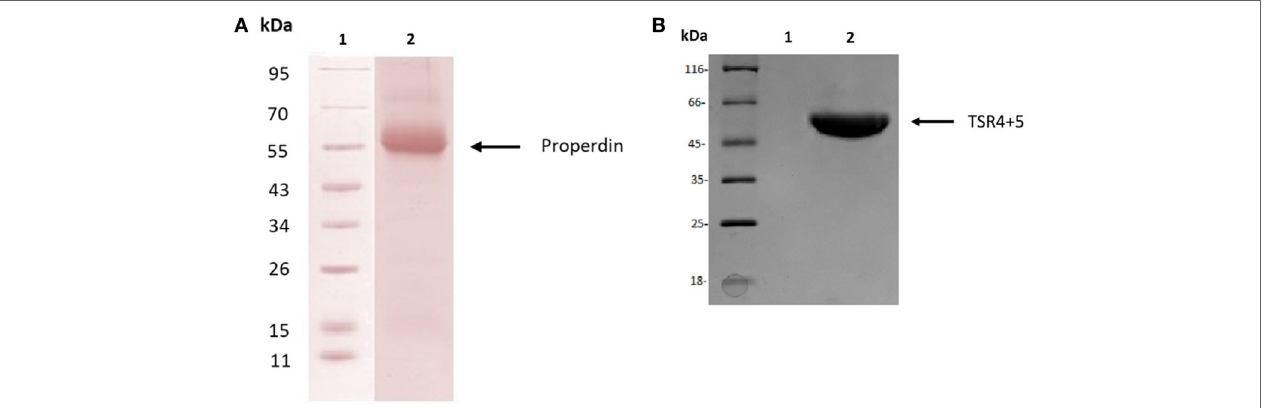
FigUre 1 | Purified human properdin and recombinant maltose-binding protein (MBP)-thrombospondin repeats (TSR) 4 + 5. (a) Properdin was purified from human plasma. Filtered plasma was applied to a non-immune IgG-Sepharose column, then to a mouse monoclonal anti-properdin Sepharose column; properdin was eluted with 3 M MgCl 2 . The eluted samples were dialyzed against HEPES buffer (10 mM HEPES, 140 mM NaCl, 0.5 mM EDTA, pH 7.4) overnight at 4°C. Contaminants were removed by applying the protein to a Q Sepharose column, and the product appears as a single band on SDS-PAGE and western blot at about 55 kDa. (B) MBP-TSR4 + 5 was purified via an amylose resin column, and the purified fusion protein also appears on SDS-PAGE as a band of about 55